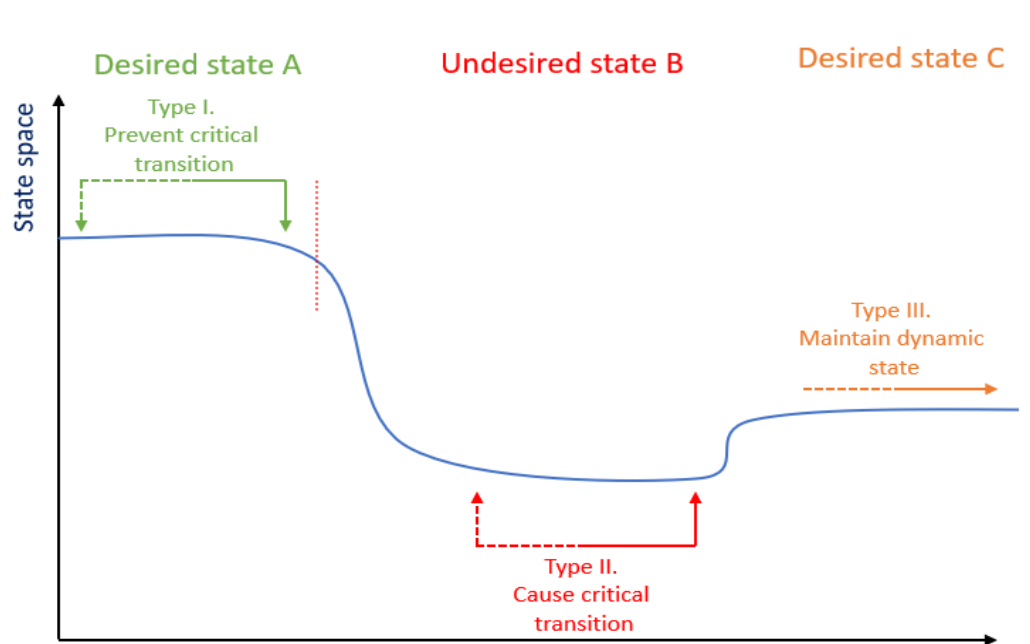
Figure 1. Illustration of complexity-science-based interventions. In terms of nonlinear dynamics, a system can move between multiple stable states as represented by the vertical axis. Type I interventions are targeted to prevent transition toward an unhealthy state, type II interventions cause a transition toward a more healthy state, and type III interventions maintain a new dynamic healthy state. Adapted from Wietmarschen et al. [43].